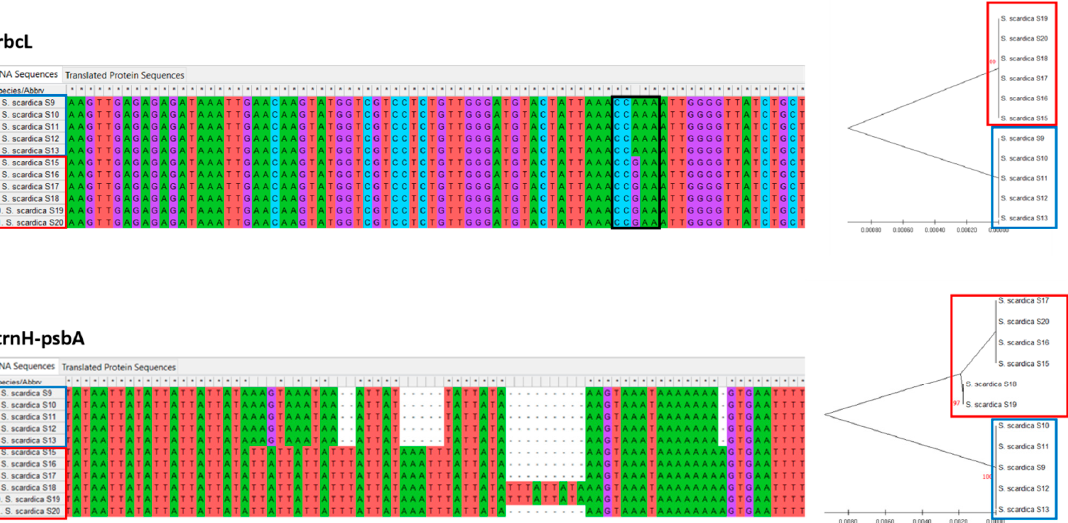
Figure 5. Genetic discrimination of Sideritis specimens from two distant floristic regions based on DNA barcodes trnH-psbA and rbcL, visualized both as a sequence alignment (partial sequences) and as a phylogenetic tree. The only single nucleotide polymorphism (SNP) between specimen populations based on the rbcL marker is indicated by a black box. The specimens from Chervenata Stena and Slavyanka Mountain are marked with blue and red boxes, respectively.